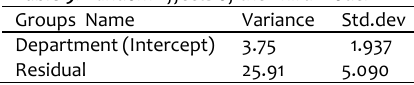
Table 9. Random Effects of the Third